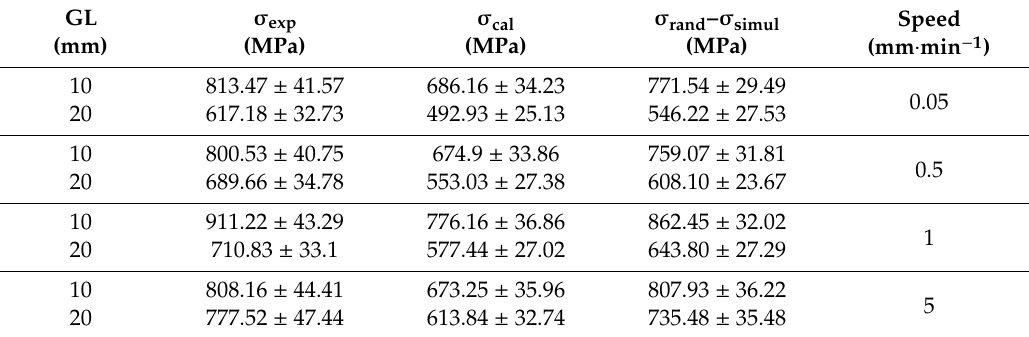
Table 4. Average values of the simulated tensile strength from the estimated parameters of the Weibull